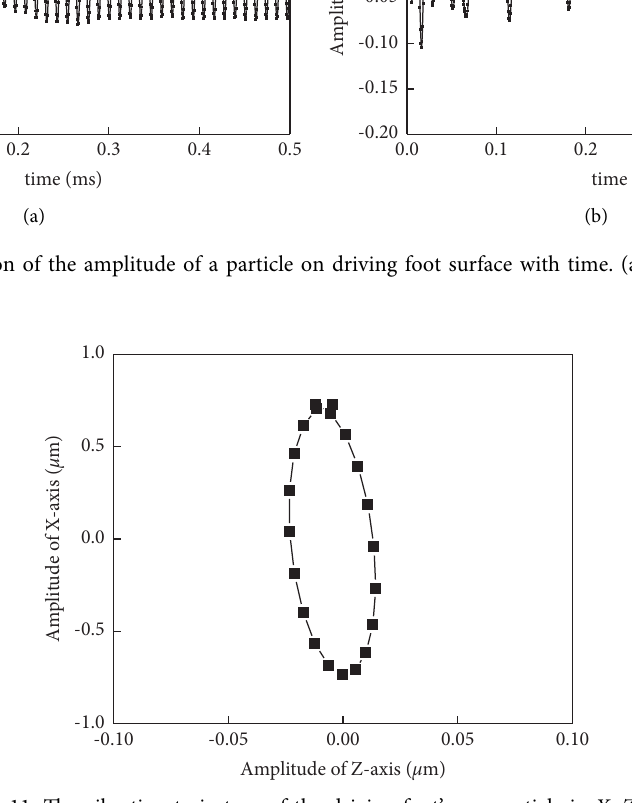
Figure 11: The vibration trajectory of the driving foot’s arc particle in X – Z plane.